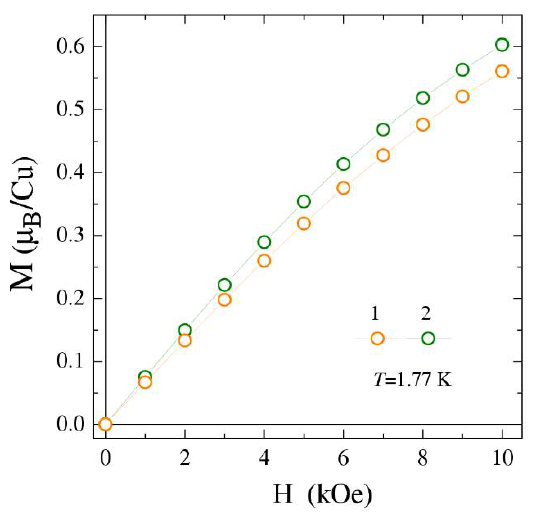
Figure 4. ( a ) Temperature dependences of the magnetic susceptibility χ measured for complexes 1 and 2 at magnetic fields H = 1; 10 kOe. ( b ) Temperature dependences of 1/ χ p determined for com- plexes 1 and 2 at H = 1 kOe together with formal high-temperature Curie–Weiss fits shown by dashed black lines. Temperature dependences of the effective moment μ eff calculated for the case of noninteracting magnetic moments ( θ = 0) fitted by a modified Bleaney–Bowers dependence (dash-dotted line), as explained in the text.